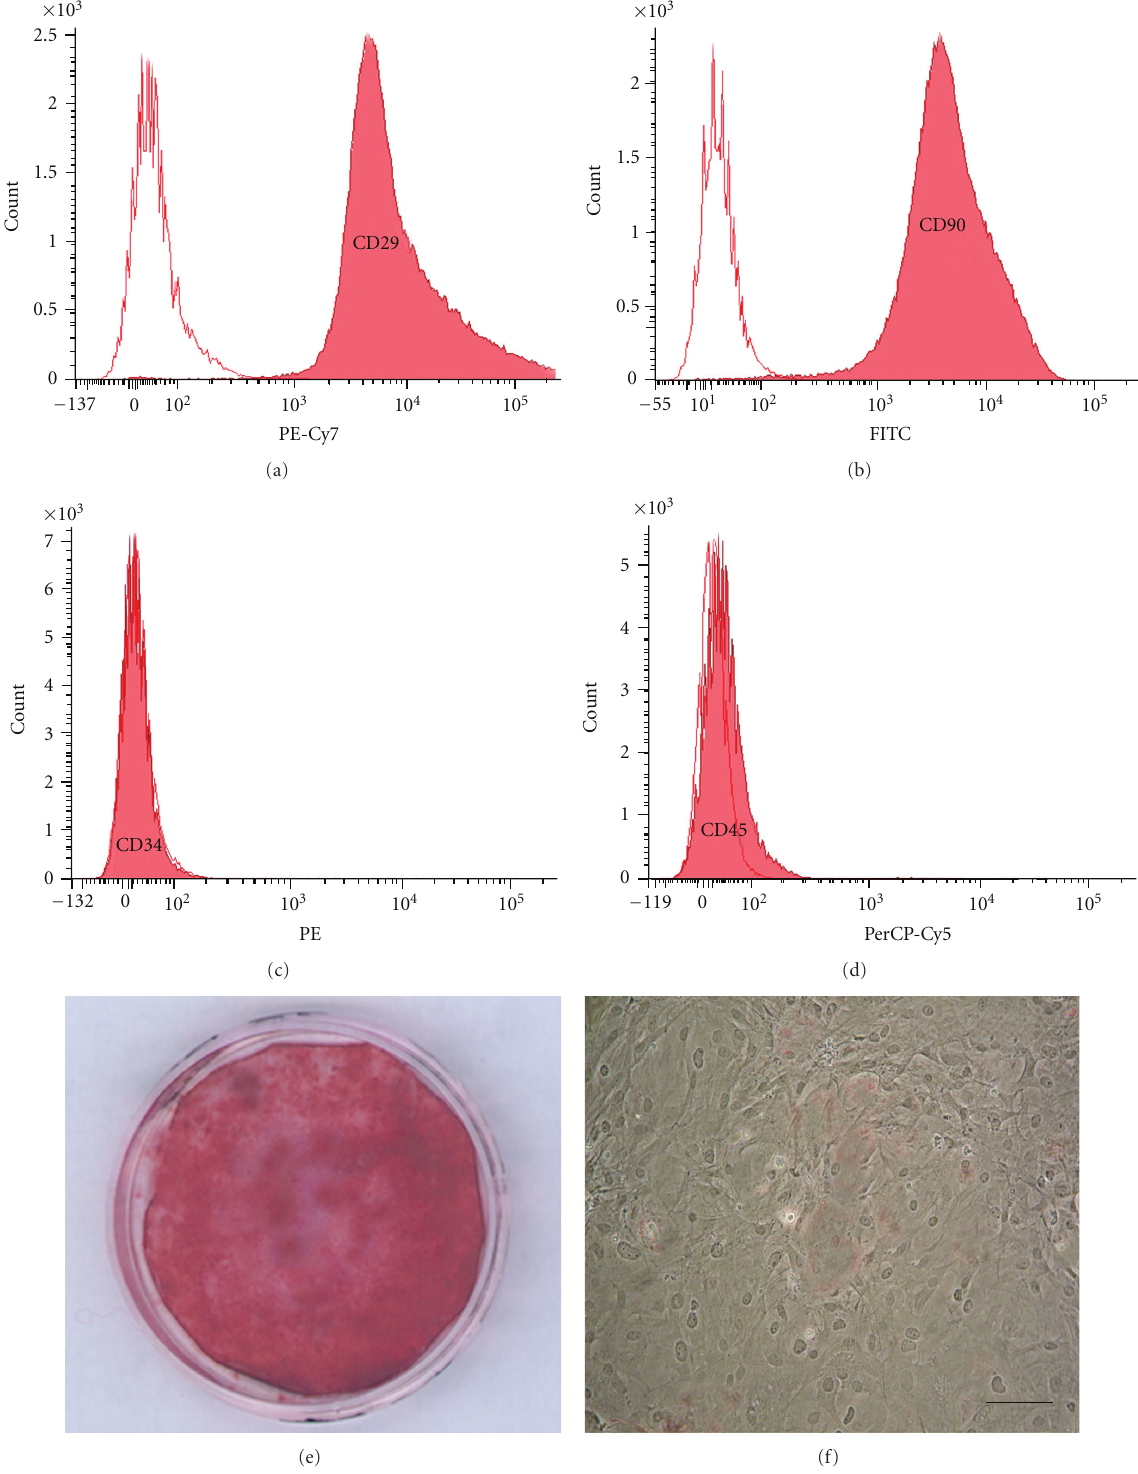
Figure 2: rMSC characterization. (a–d) rMSCs, at P80, were characterized by flow cytometry analysis for the expression of the following markers (pink histograms): CD29 (a), CD90 (b), CD34 (c), and CD45 (d). Isotype-matching IgGs were used to determine nonspecific signals (white histograms). (e and f) rMSC di ff erentiation, at P80, after treatment with specific induction media: osteogenic di ff erentiation was evaluated by alizarin red staining that visualizes calcium deposits (e), adipogenic di ff erentiation was evaluated by oil red O staining that labels lipid droplets, not observed in adipogenic treated rMSC cultures at P80 (f). Bar: 100 μ